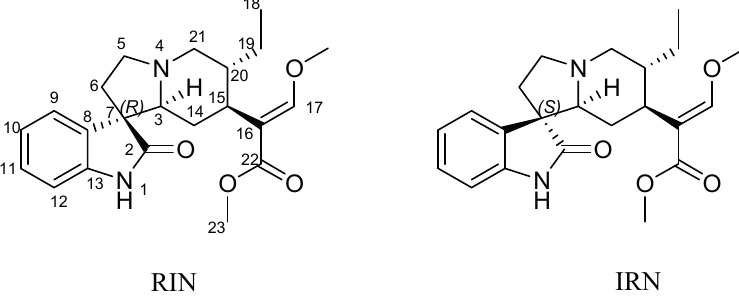
Figure 1. The chemical structure of rhynchophylline (RIN) and isorhynchophylline